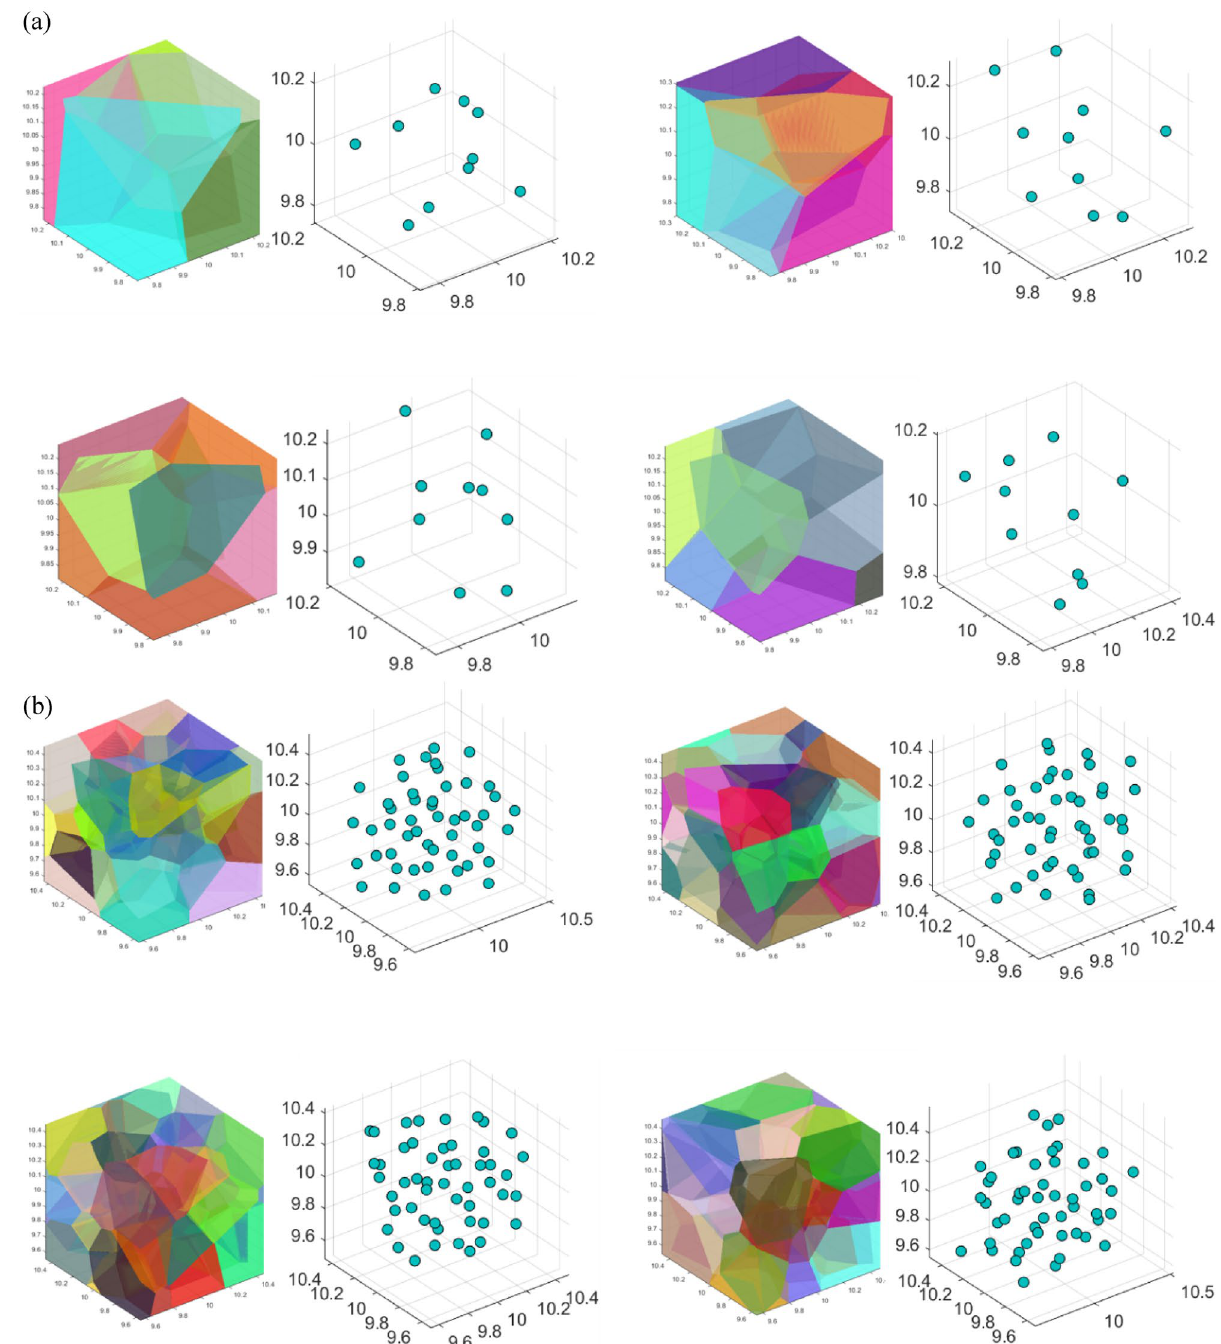
Figure 3. Representative Voronoi cells with ( a ) 10 and ( b ) 50 seeding points produced by the proposed